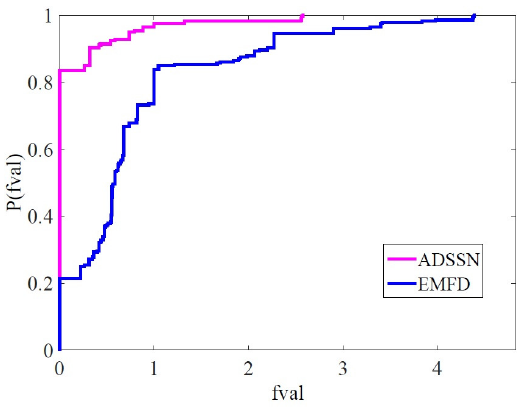
Figure 5. Performance profile of ADSSN versus EMFD [8] with respect to fval .